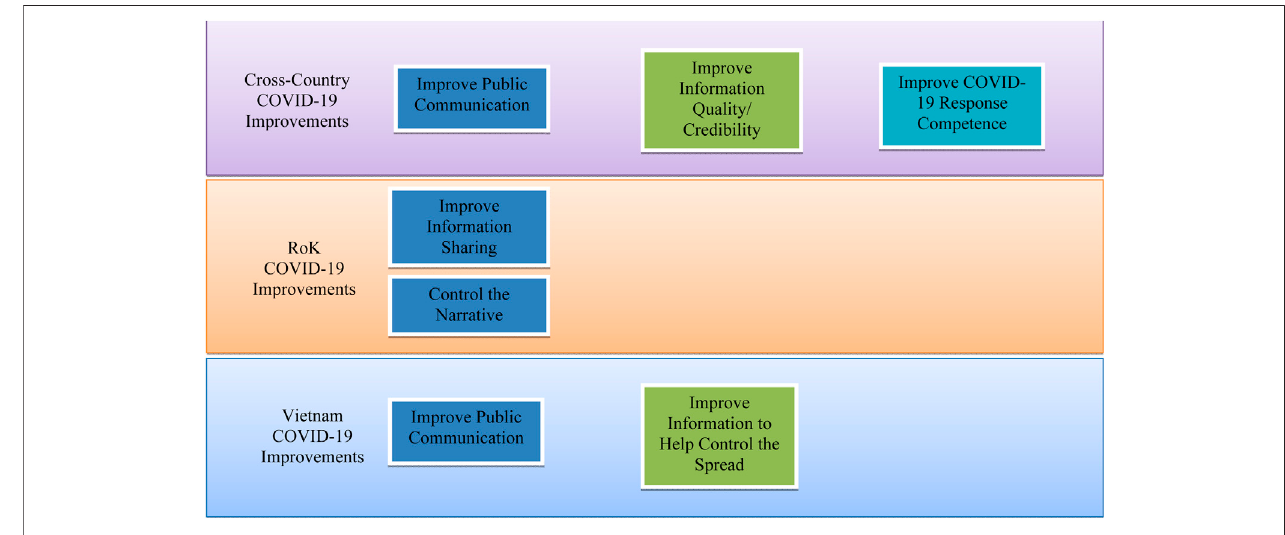
FIGURE 6 | Evaluating how the RoK and Vietnamese governments could respond better to